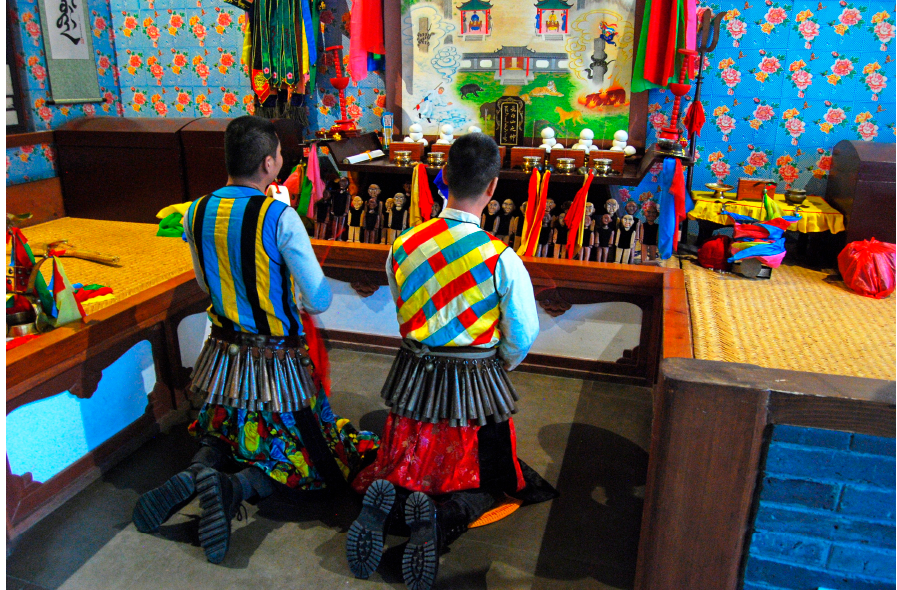
Figure 1. The shaman Shi Guanghua and Shi Zongduo of the Manchu Shi Clan performed a ritual for the author’s observation in January on 30 January 2023. Photograph by Feng Qu.